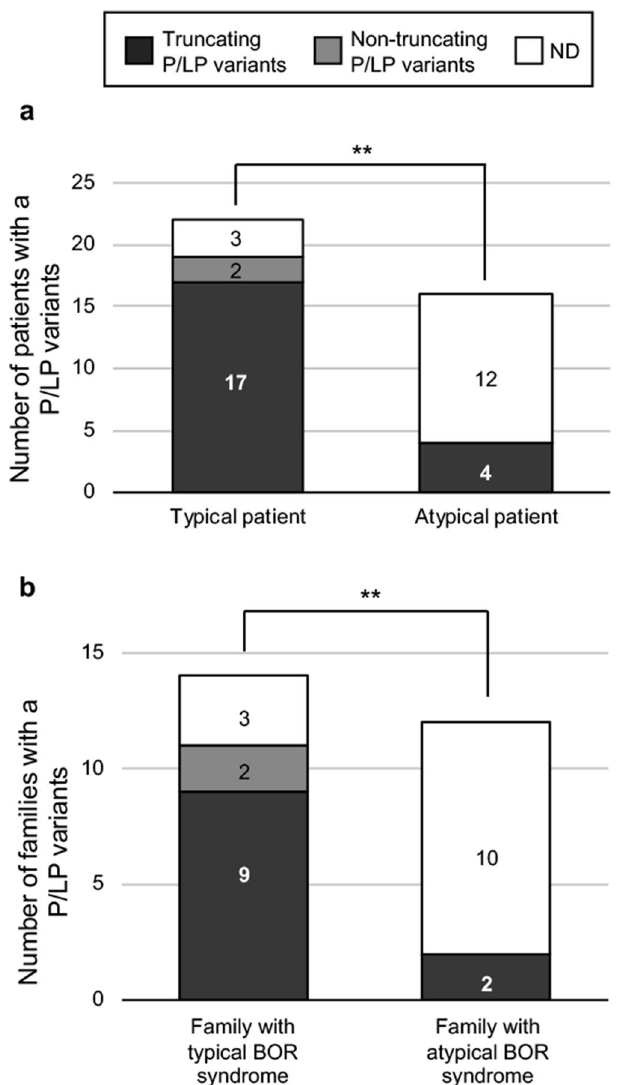
Figure 3. Numbers of patients/families with P/LP variants. ( a ) Patients with typical and atypical BOR syndrome. ( b ) Families with typical and atypical BOR syndrome. **Significant difference at p < 0.01 (Fisher’s exact test). ND, P/LP variants were not